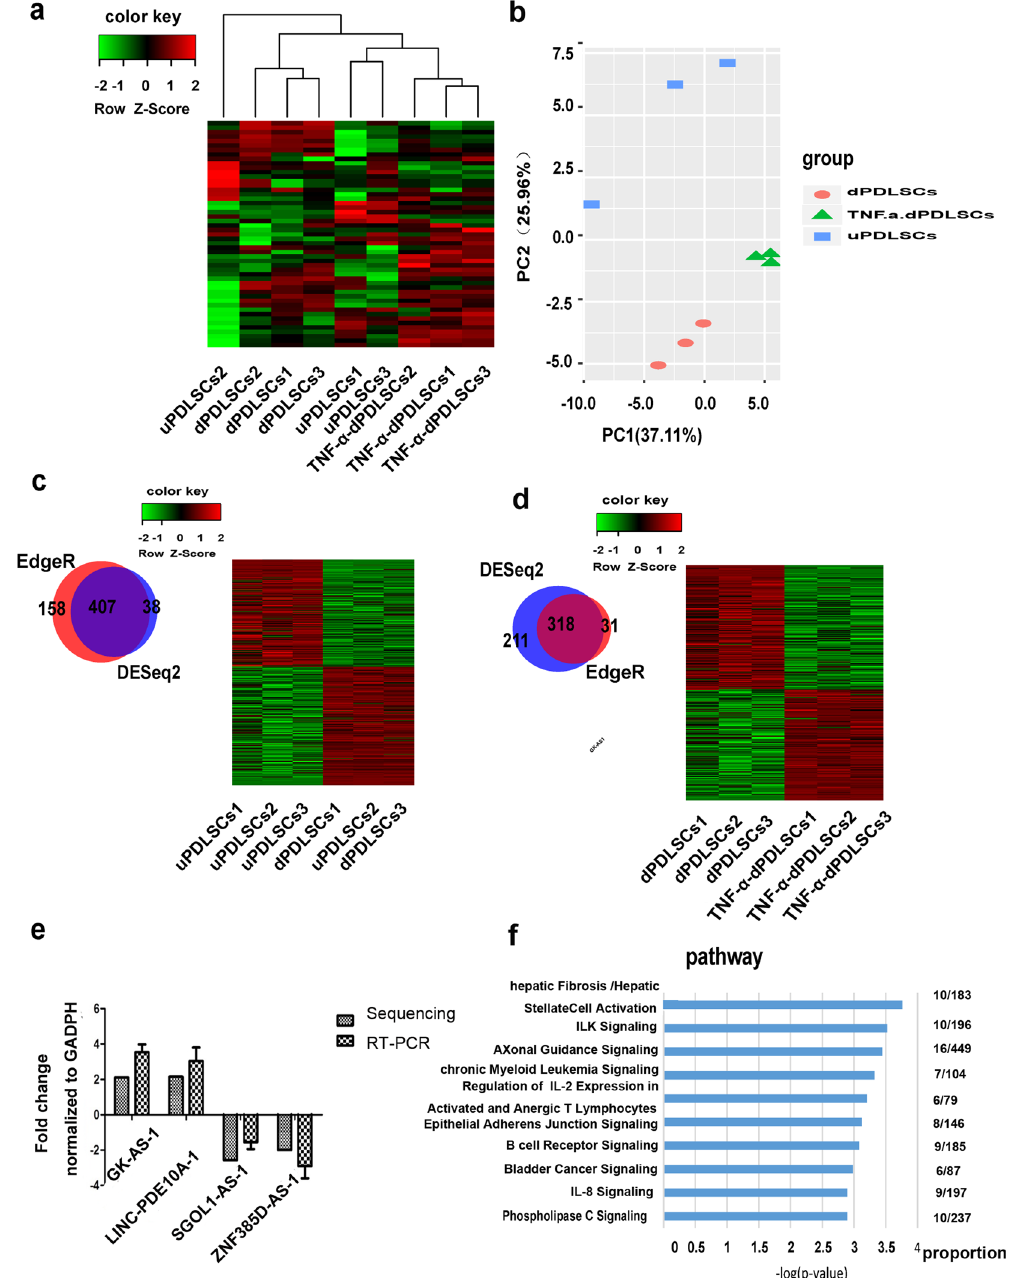
Figure 4. Differential expression of lncRNAs during osteogenic differentiation. ( a ) Heatmap showing the hierarchical clustering result of all expressed lncRNAs of the three PDLSCs subsets. ( b ) The principal component analysis of three cell types based on all expressed lncRNAs of the three subset types. ( c ) The number of differentially expressed (DE) lncRNAs between uPDLSCs and dPDLSCs detected by EdgeR and DESeq2 are shown in the Venn plot. Heatmap showing the overlapping DE lncRNAs between EdgeR and DESeq2. ( d ) The number of differentially expressed (DE) lncRNAs between dPDLSCs and TNF- α -dPDLSCs detected by EdgeR and DESeq2 are shown in a Venn plot. Heatmap showing the overlapping DE lncRNAs between EdgeR and DESeq2. ( e ) The fold changes of four lncRNAs ( CK-AS1, LINC-PDE10A-1, SGOL1-AS-1, ZNF3650-AS-1 ) measured by qRT-PCR and sequencing. ( f ) Top ten KEGG pathways for neighboring protein-coding genes for DE lncRNAs between TNF- α -dPDLSCs and